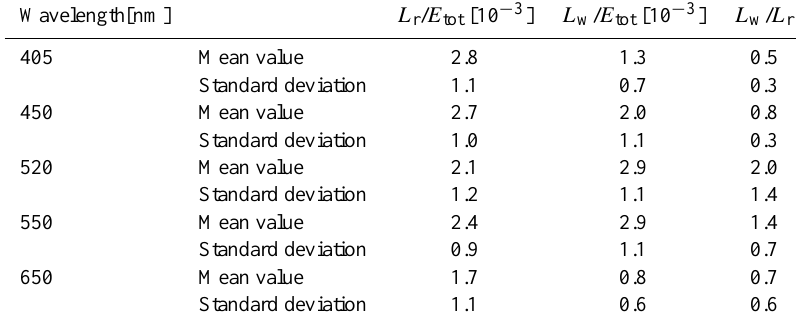
Table 6. Estimates of the ratio between water-leaving and reflected radiances. W =1.5–7.5ms − 1 , θ s =37 ◦ –52 ◦ .